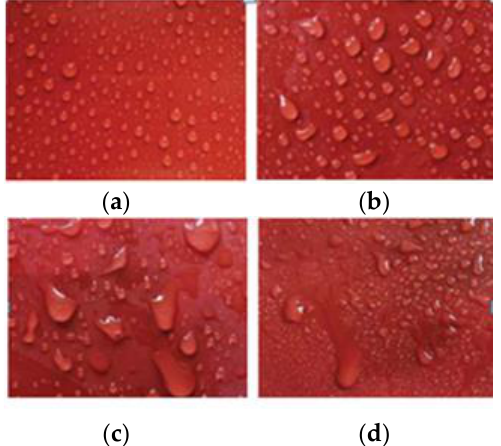
Figure 3. Hydrophobicity grading diagram. ( a ) HC1; ( b ) HC2; ( c ) HC3; ( d ) HC4.